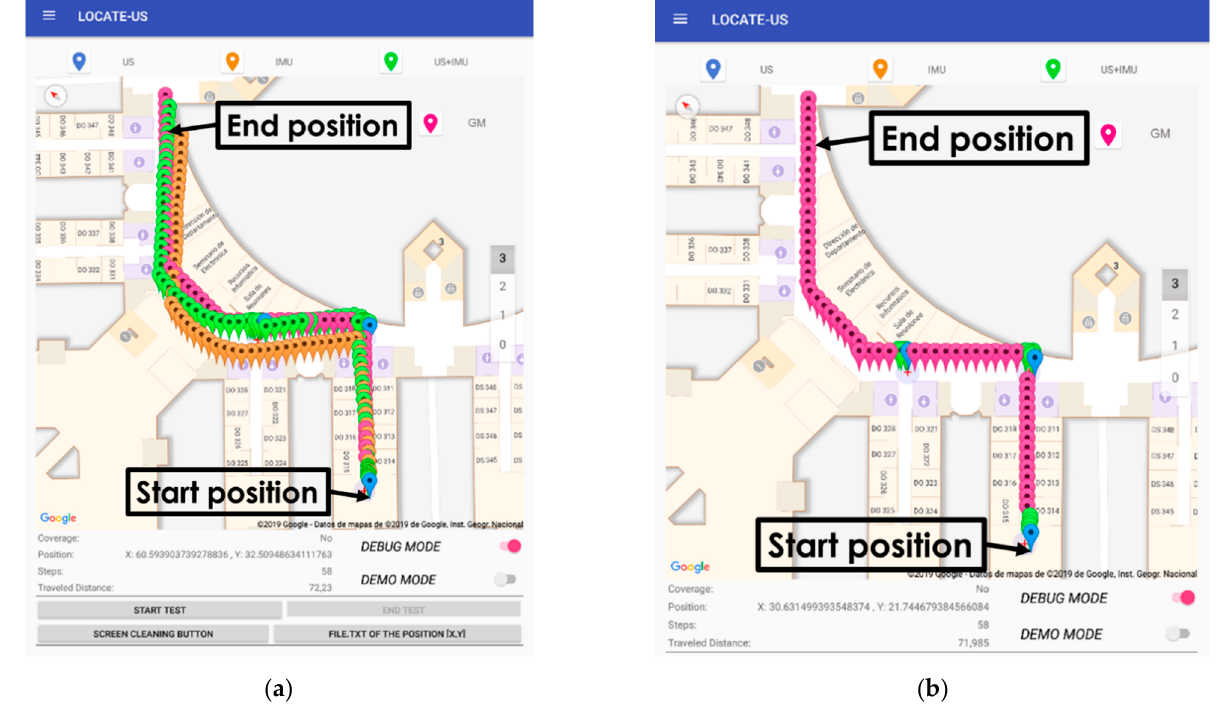
Figure 21. Android screenshots of the experimental test which includes the graph-matching technique. ( a ) Fusion (US+IMU), US, IMU and GM; ( b ) Fusion (US), US and GM.